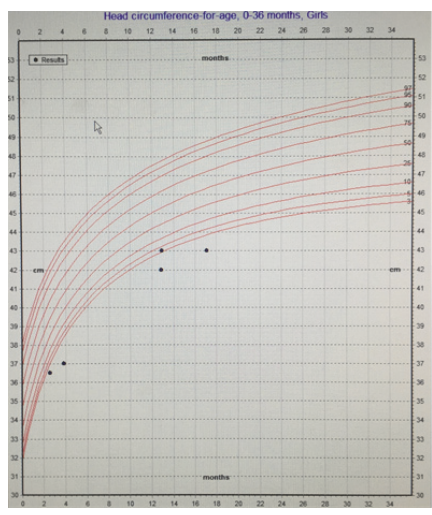
Figure 6: Patient’s growth chart—head circumference for